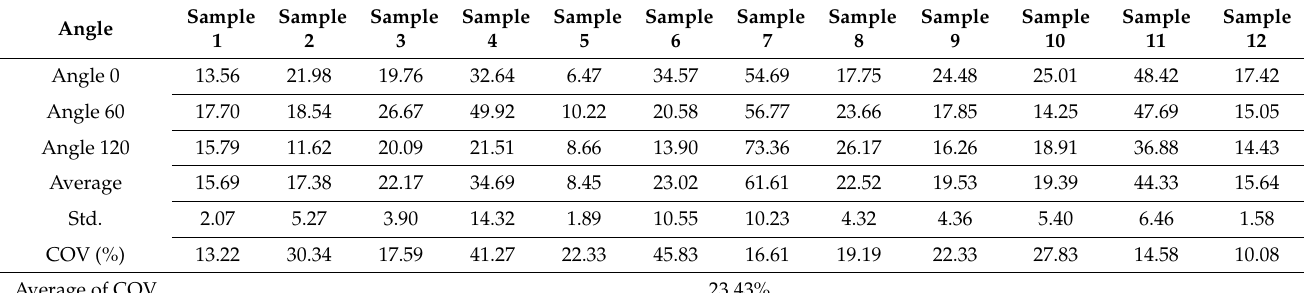
Table A3. Diffusion coefficient of 12 concrete samples tested from three angles (D ac × 10 − 12 m 2